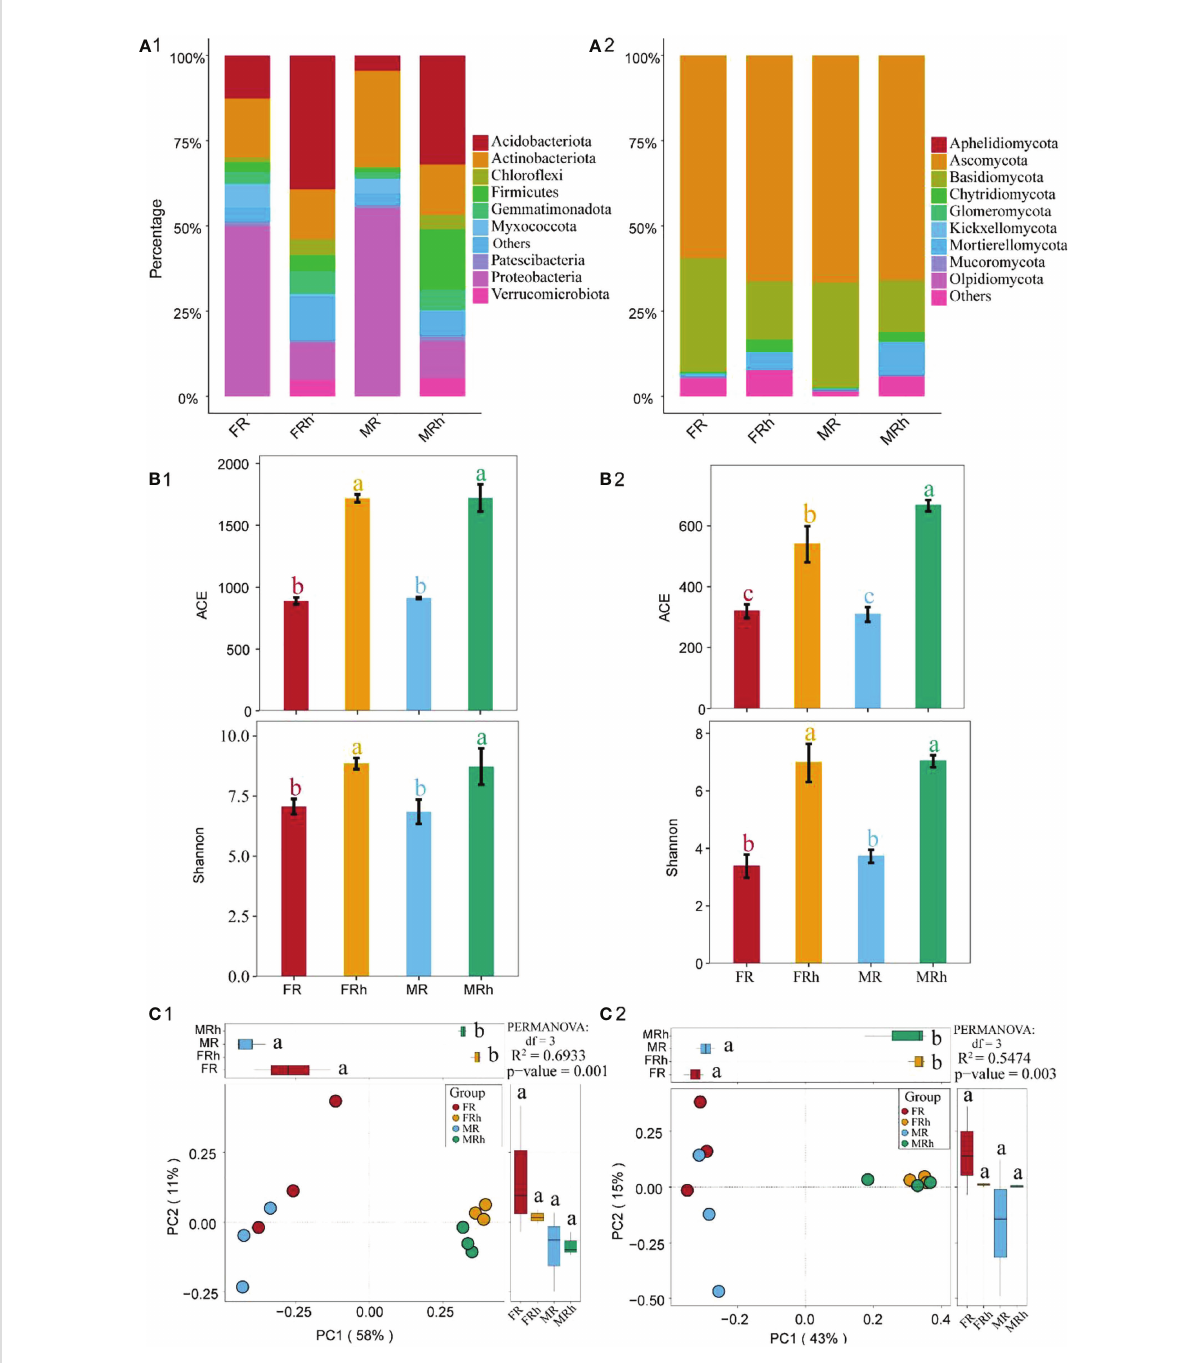
FIGURE 4 Taxonomic composition of the bacteria (A1) and fungi (A2) in the roots and rhizosphere soils of the female and male papaya. Alpha diversity analysis showed the richness index (ACE index) and diversity index (Shannon index) of bacteria (B1) and fungi (B2) in the roots and rhizosphere soils between the male and female papaya. The different letters meant a signi fi cant difference (p< 0.05). PCoA analysis demonstrating bacteria (C1) and fungal (C2) diversity in the roots and rhizosphere soils between the female and male papaya. The differential analysis was performed on PC1 and PC2 to reveal the differences in microbial composition. Different letters represented signi fi cant differences (P < 0.05). Permanova analysis revealed signi fi cant differences between every two sample groups (P <